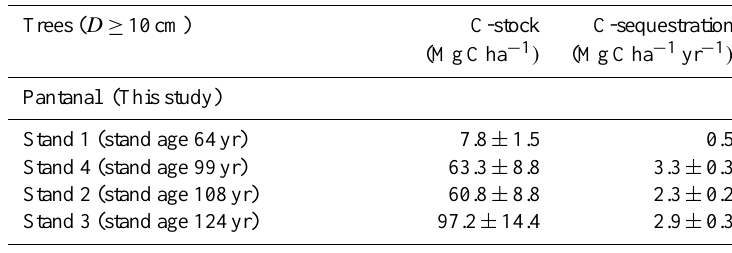
Table 6. Comparison of C-storage, C-sequestration and C-turnover in AGWB of successional stages in wetland forests of the northern Pantanal and floodplain forests in the central